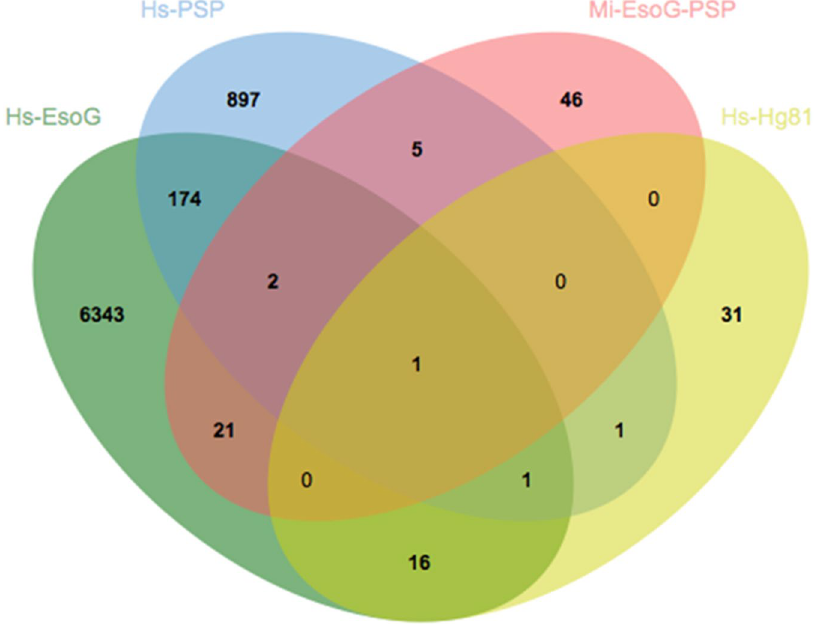
Figure 6. Venn diagram depicting the overlapping of H. schachtii sequences with other nematodes. The Venn diagram represents H. schachtii esophageal gland related sequences (HsEsoG) and H. schachtii putative secretory proteins (HsPSP) with homologous esophageal gland putative secretory proteins from M. incognita and H. glycines